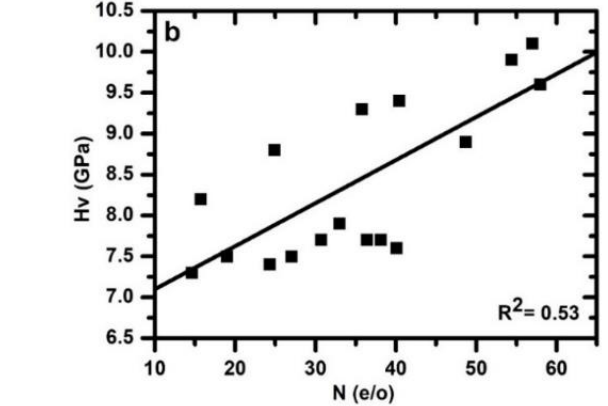
Figure 4. ( a ) Microhardness as a function of glass atomic packing density ( b ) microhardness as a function of nitrogen content (in e/o).